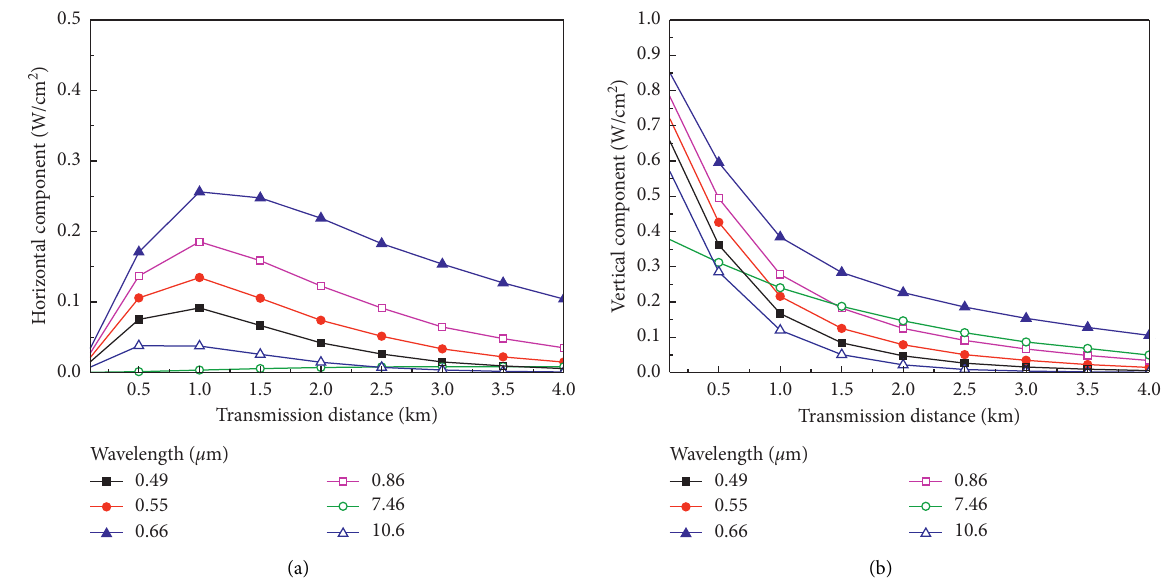
Figure 2: Vertically polarized laser [1, − 1, 0, 0] transmitted in the Martian dust: (a) horizontal component of vertically polarized laser [1, − 1, 0, 0] varying with the transmission distance and (b) vertical component of vertically polarized laser [1, − 1, 0, 0] varying with the transmission